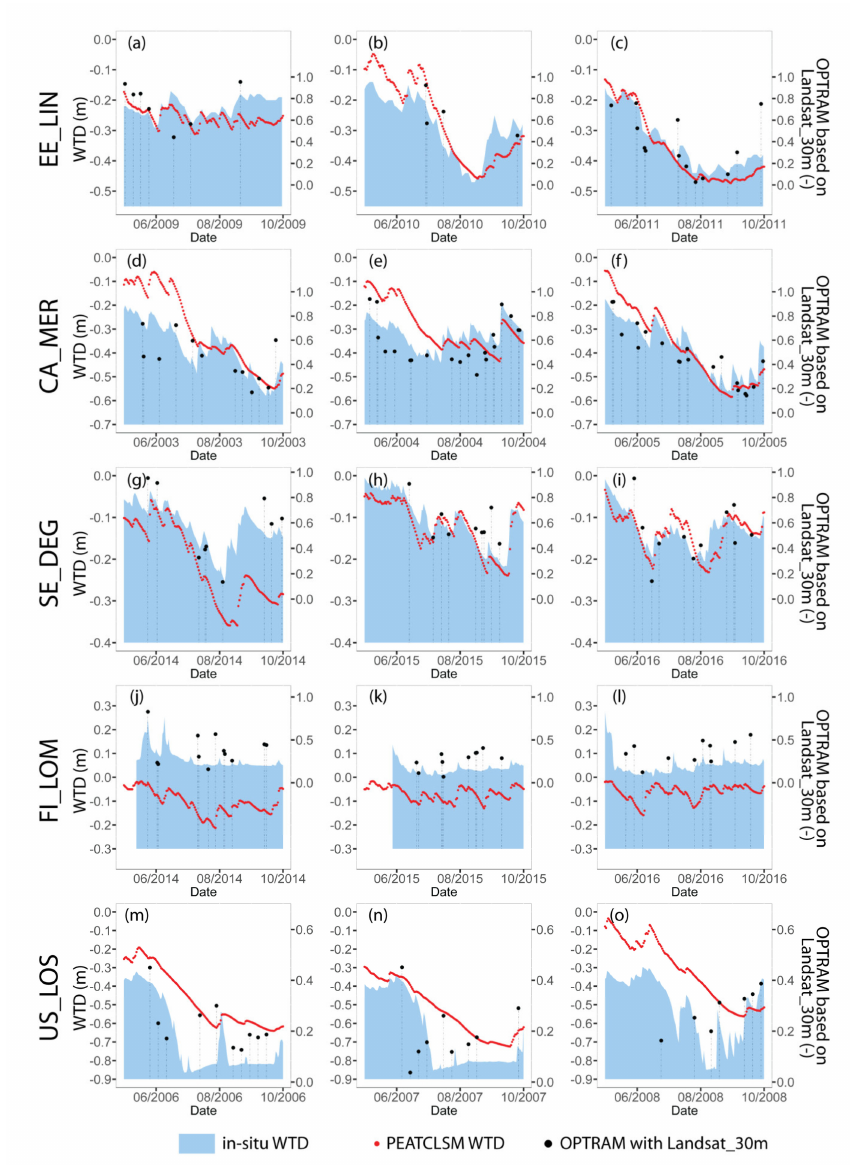
Figure 8. Exemplary three-year periods (vegetation season only) of the long-term time series of water table depth (WTD) measured in situ and modeled with PEATCLSM, and OPTRAM based on Landsat_30m for EE_LIN (panels a–c ), CA_MER (panels d–f ), SE_DEG (panels g–i ), FI_LOM (panels j–l ) and US_LOS (panels m–o ). OPTRAM values are shown for the ‘best pixel’ within each peatland site. For better visual comparison, the OPTRAM range is adjusted to the in situ WTD range of each site for the shown period. The abbreviations of peatlands are given in Table